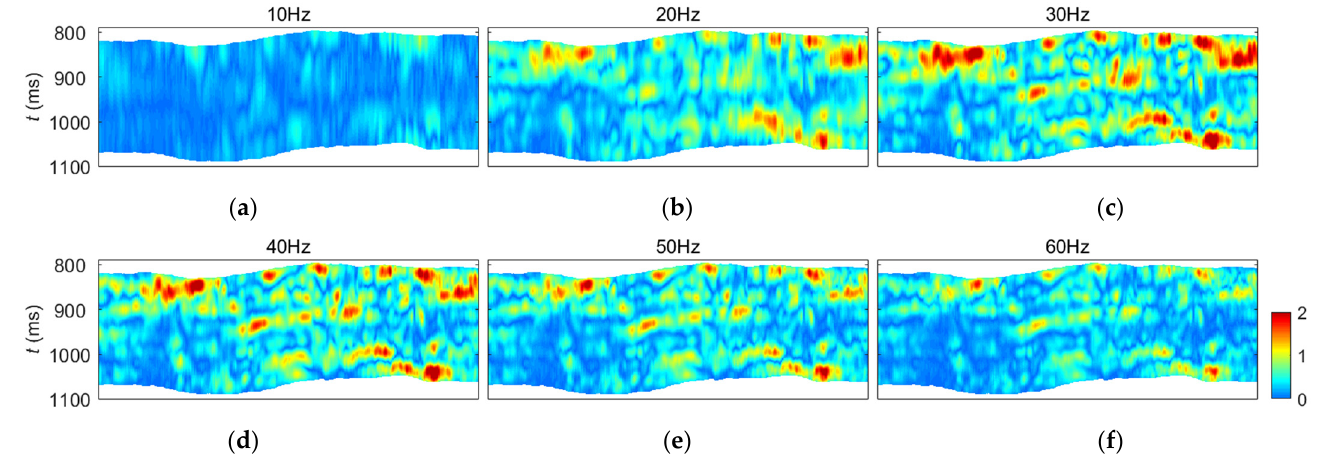
Figure 12. Spectral decompositions of the seismic profile in Figure 11, calculated using CWT at frequencies of ( a ) 10 Hz, ( b ) 20 Hz, ( c ) 30 Hz, ( d ) 40 Hz, ( e ) 50 Hz, and ( f ) 60 Hz.